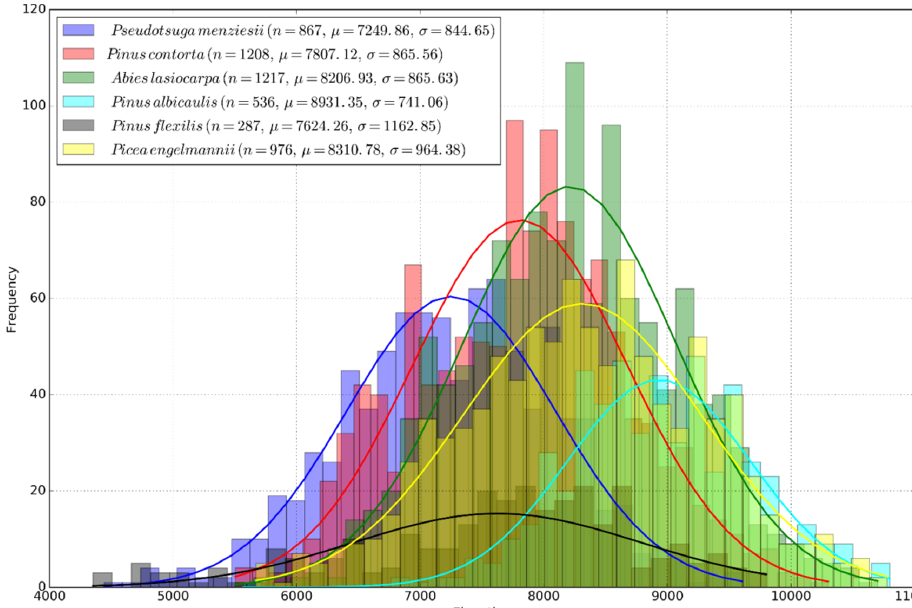
Figure 3. Frequency of occurrence of the major conifer species along the elevational gradient in the GYE as derived from Forest Inventory and Analysis data